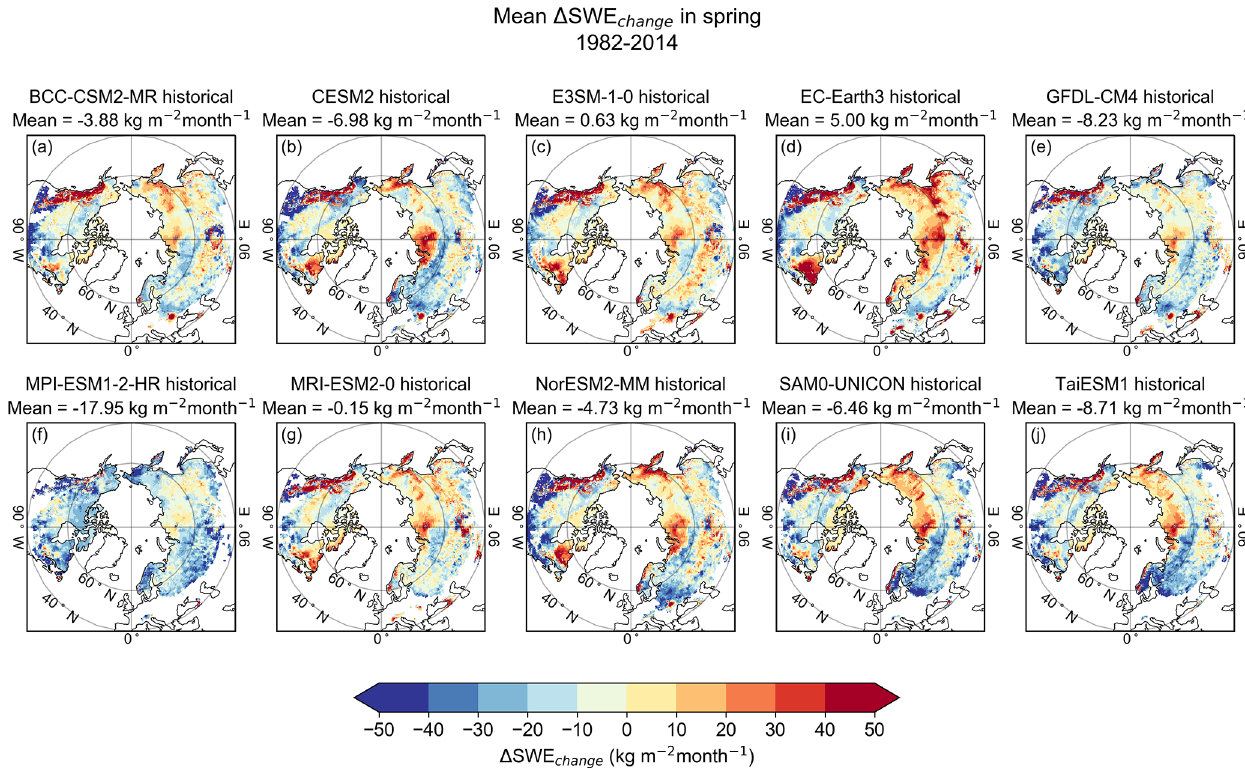
Figure 8. The mean model bias in the monthly SWE change ( (cid:49) SWE change , model minus observation) in spring for the period 1982–2014.